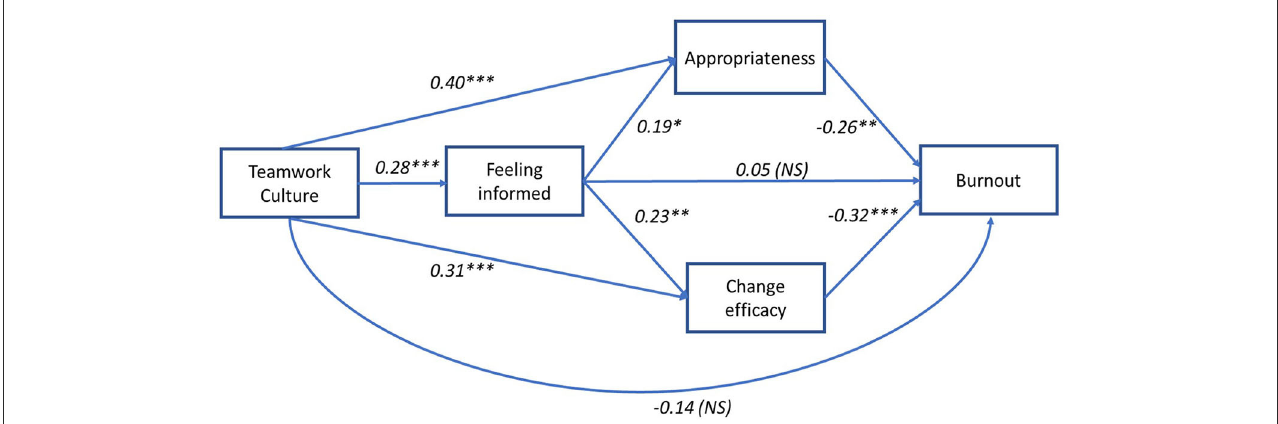
FIGURE2 Explanatory path model for the influence of teamwork culture on burnout and the role of feeling informed and change readiness during organizational change with regression coefficients (B). ** P < 0.00I, NS, not significant.